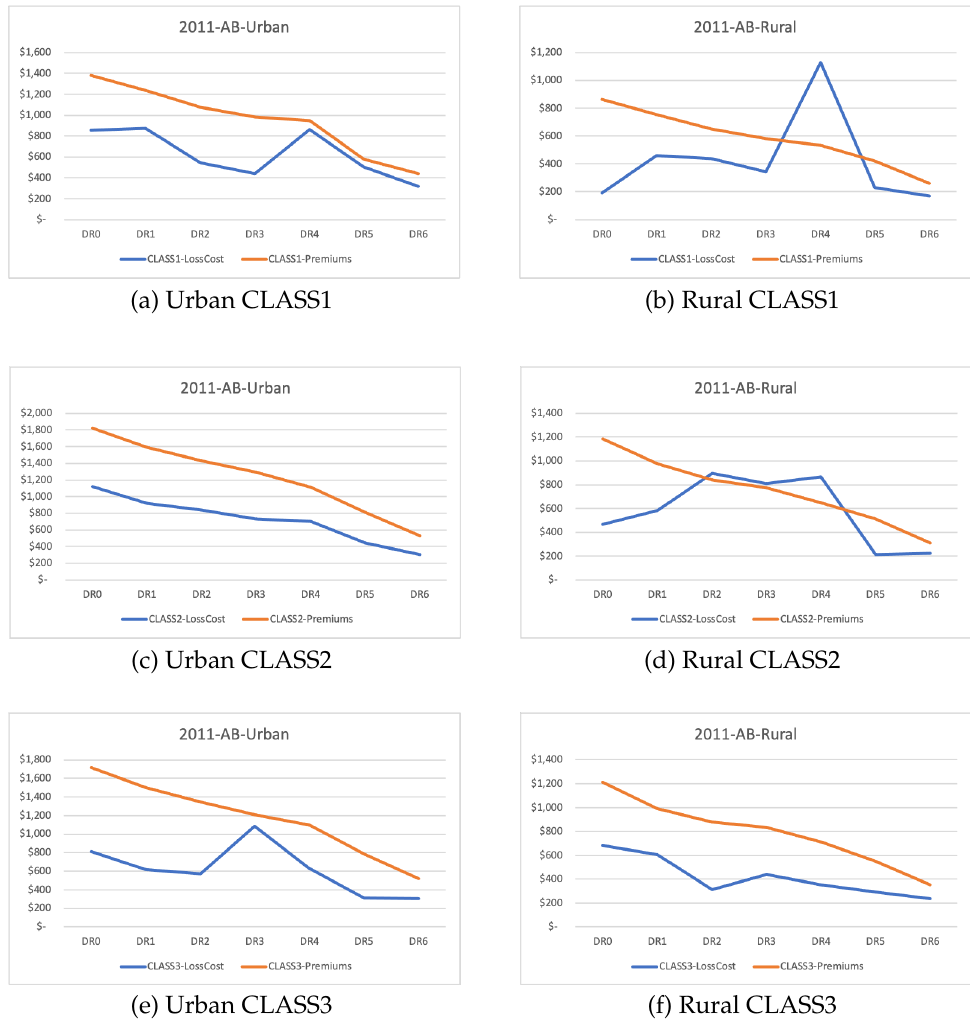
Figure 1. Comparison of loss costs and premiums as a function of DR for the first three classes in the accident year 2011 and AB